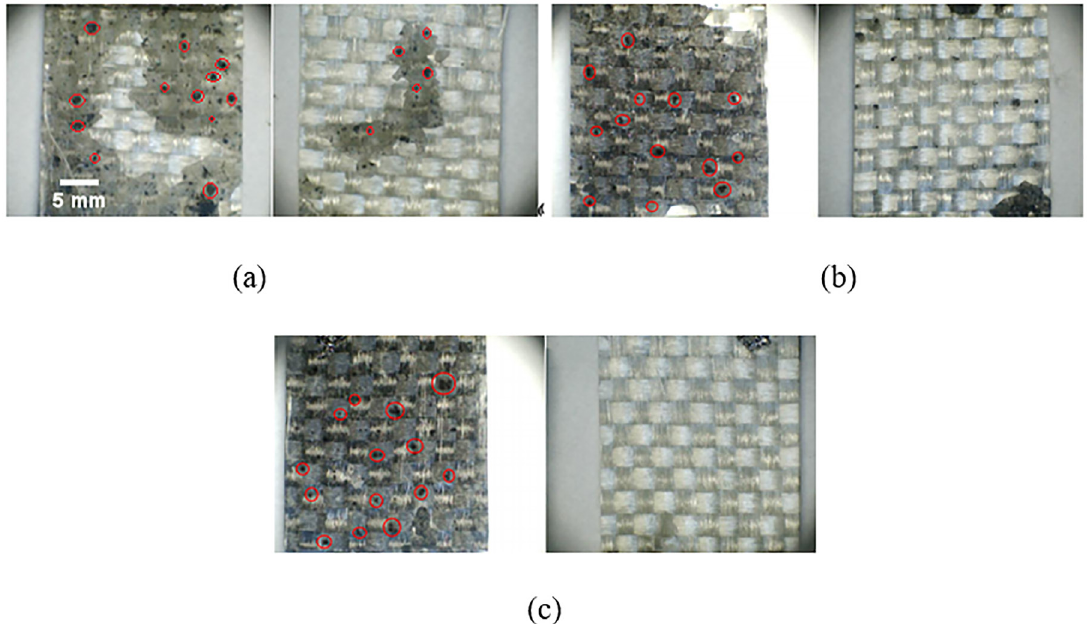
Figure 5. CNT agglomerates visible on failure region: (a) Group A05-015; (b) Group A10-015; (c) Group A20-015.